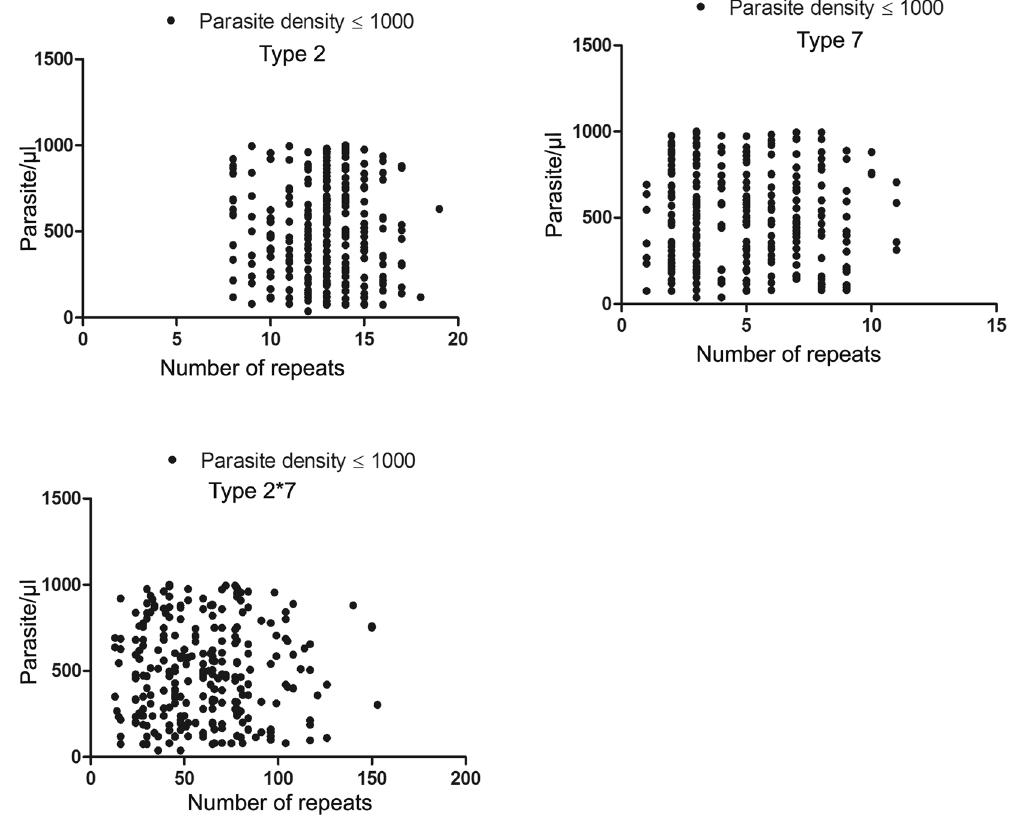
Figure 3. Association between parasite density and number of repeat among the samples having ≤ 1000 parasite per microlitre. Parasite density in Type 2, Type 7 and Type 2 × 7